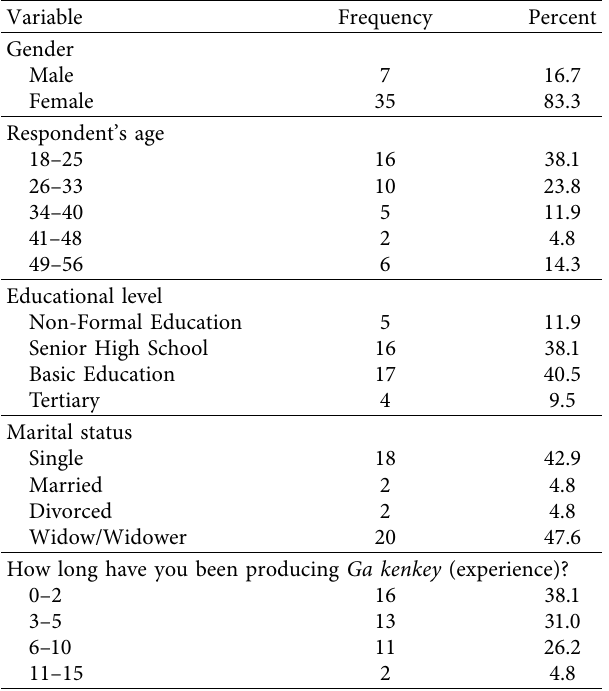
Table 1: Sociodemographic characteristics of Ga kenkey